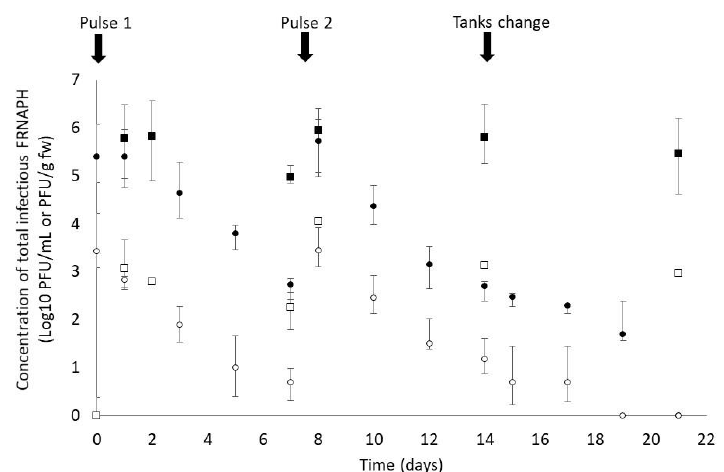
Figure 3. Concentrations of infectious FRNAPHs in water and mussel soft tissue during the con- tamination and depuration periods. Results are expressed in Log 10 PFU/mL for the FRNAPH con- tent of the water and PFU/g of fresh weight for the FRNAPH content of the mussels. Squares: FRNAPHs in the mussels; circles: FRNAPHs in the water; black: high-density suspension (100X); white: low-density suspension (1X). D0 and D7: inoculation of FRNAPHs containing a ratio of 30% of GGI (subgroup I) in the form of MS2 phages and 70% of GGII (subgroup II) in the form of GA phages. The water was changed in all tanks on day